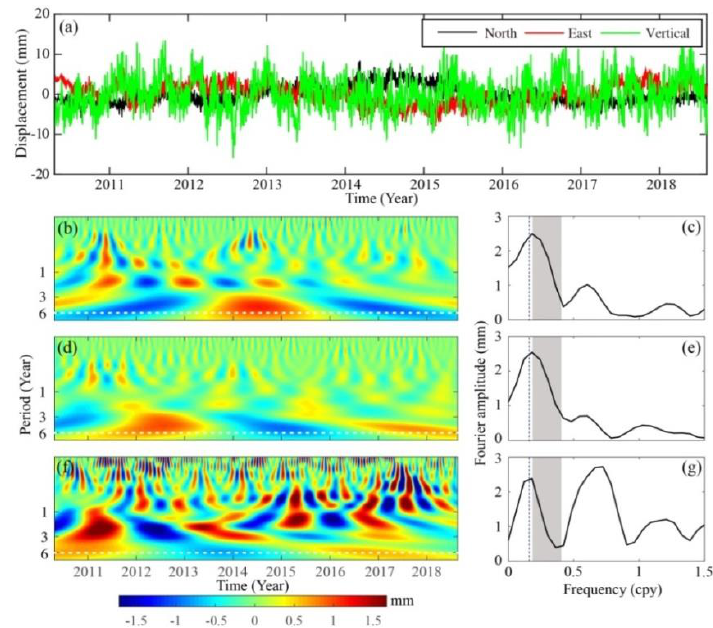
Figure 8. Spectrum analysis of common mode components in the short-term GPS time series. ( a )–( g ) are the same as those in Figure 7. The gray areas in ( c ), ( e ), and ( g ) are used to compare the different spectral peaks around the 3–6yr (the vertical dashed lines), comparing with the spectral peak in ( g ), the corresponding spectral peaks in ( c ) and ( e ) are clearly wider. This means that there are some other signals presented in the 3–6 yr period band in the Northern and Eastern components. The wavelet spectra in ( b ), ( d ), and ( f ) also confirm this result.